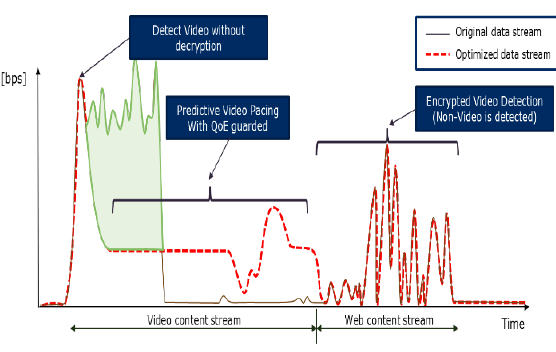
Figure 5. Optimisation using